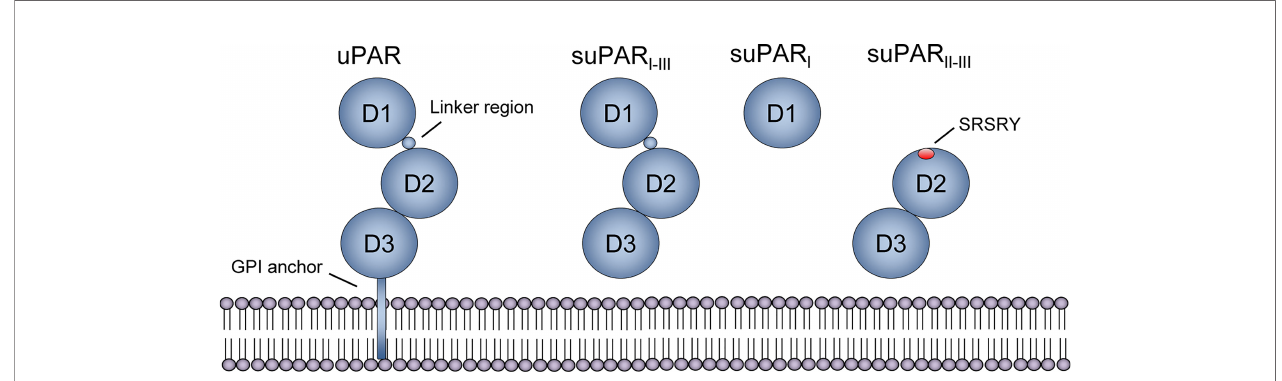
FIGURE 2 | Structure of uPAR and suPAR isoforms. Soluble urokinase plasminogen activator receptor (suPAR) is the soluble form of the membrane-bound receptor uPAR, which is tethered to the membrane by a glycosyl phosphatidylinositol (GPI) anchor. The protein consists of three domains, D1-D3, that are connected with a linker region between D1 and D2D3. Several cleavage sites exist, both in the linker region and the GPI anchor, and proteolytic cleavage generates three suPAR isoforms: full-length suPAR I-III , suPAR I , and suPAR II-III . Cleavage of uPAR/suPAR in the linker region exposes an SRSRY sequence, which is involved in chemotaxis. Reprinted from Rasmussen, LJH (2018) (19)